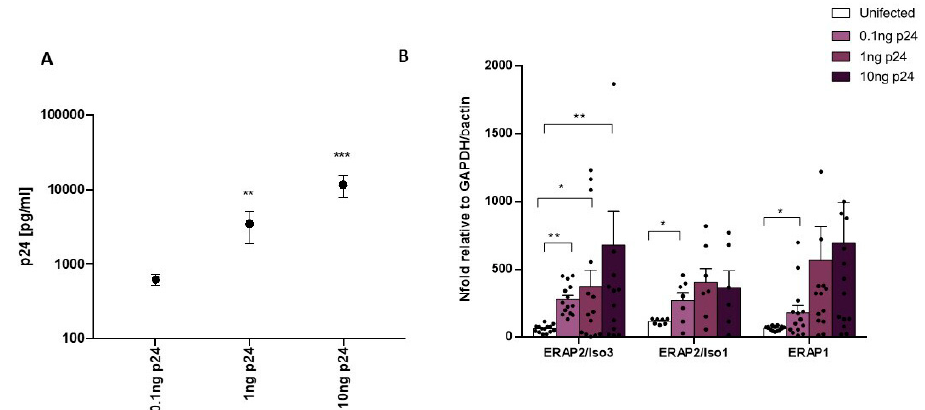
Figure 5. In vitro HIV-1 infection assay on PBMCs. ( A ) HIV-1 replication was assessed by p24 quantification on PBMCs isolated from 8 HeteroAB and 6 HomoB individuals infected with 0.1, 1, and 10 ng p24 HIV-1Bal/1 × 10 6 PBMCs 5 days post infection. Results showed a significant increase in viral replication according to the increased viral input. ( B ) ERAP2/Iso3, Iso1, and ERAP1 mRNA expression by in vitro HIV-1-infected PBMCs increased according to the rising viral input. Mean values ± ES are reported. * = p < 0.05; ** = p < 0.01; ***= p < 0.001.